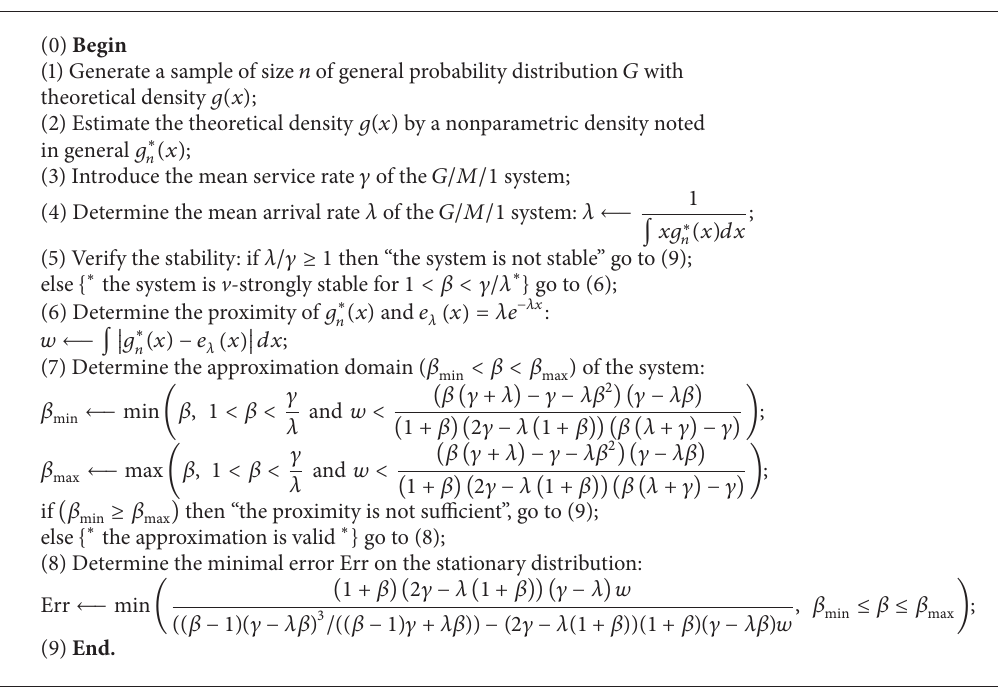
Algorithm 2: Approximation error with the weight